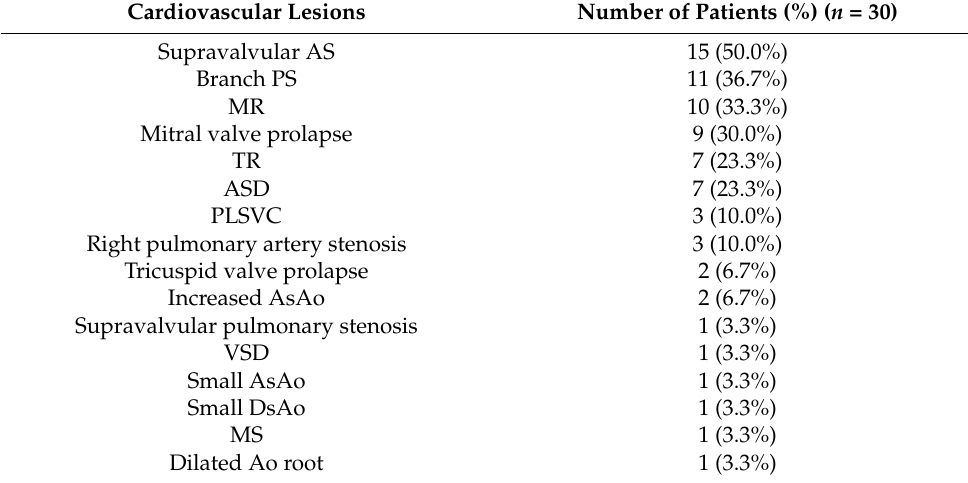
Table 1. Number and percentage of cardiovascular lesions in Williams syndrome.